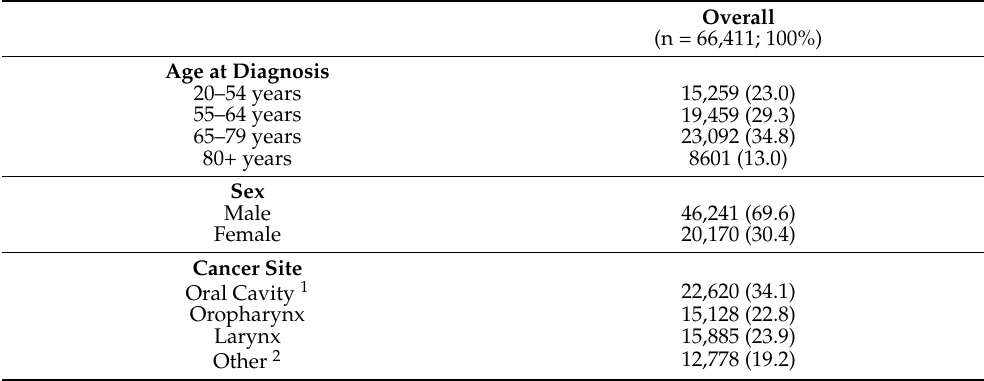
Table 1. Demographic and clinical characteristics of HNC diagnosed during